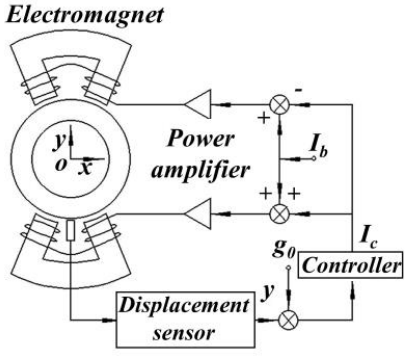
Figure 2. Basic control loop.